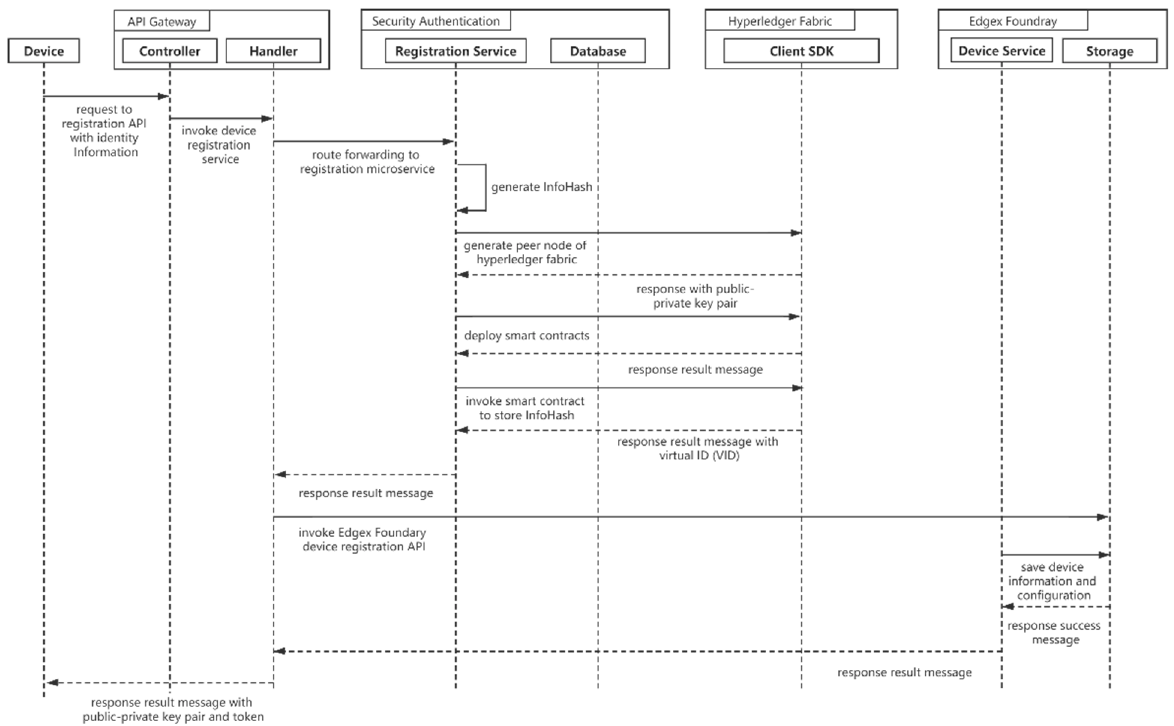
Figure 3. Sequence diagram for device registration.